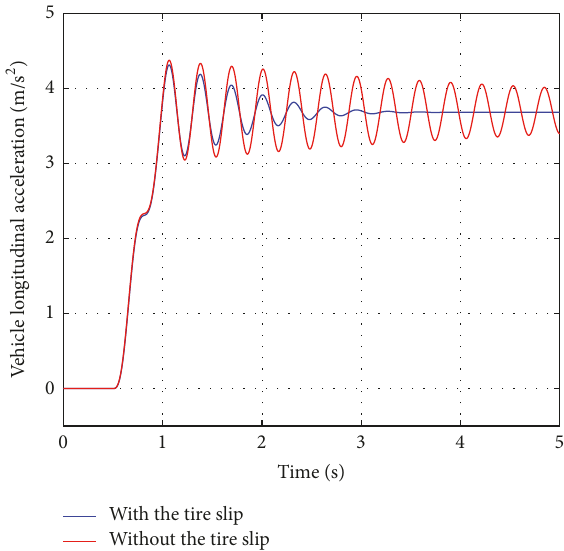
Figure 11: Longitudinal acceleration of the model with/without the tire